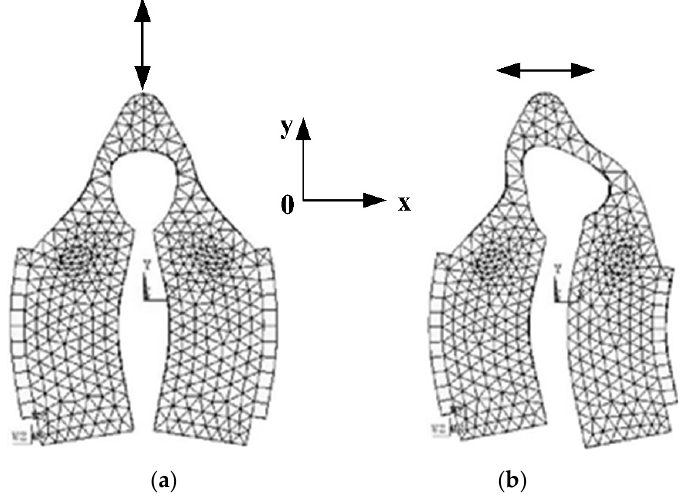
Figure 6. The stator finite element model of the patch structure: ( a ) Symmetrical mode frequency 71,454 Hz; ( b ) Anti-symmetrical modal frequency 70,334 Hz.